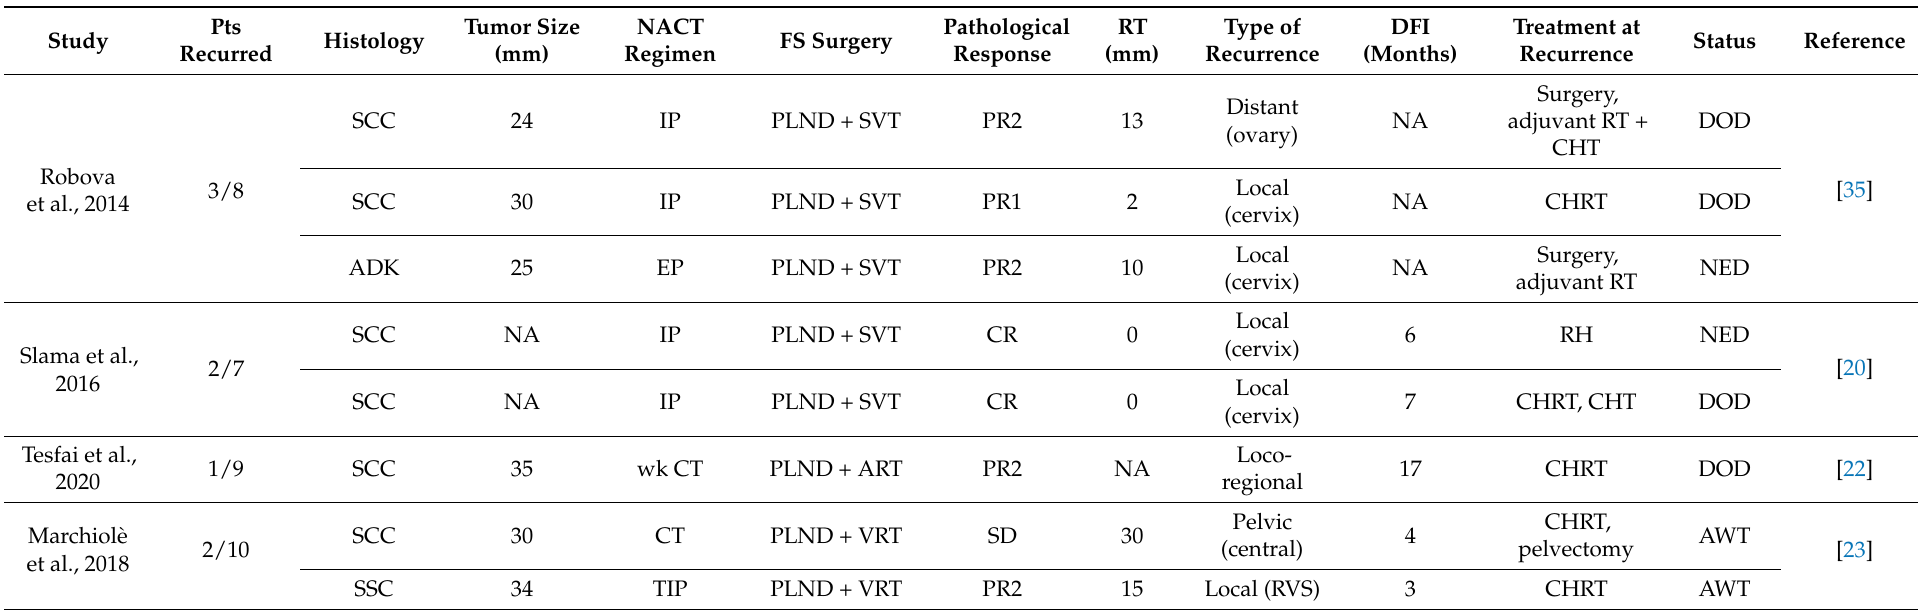
Table 3. Analysis of cases of